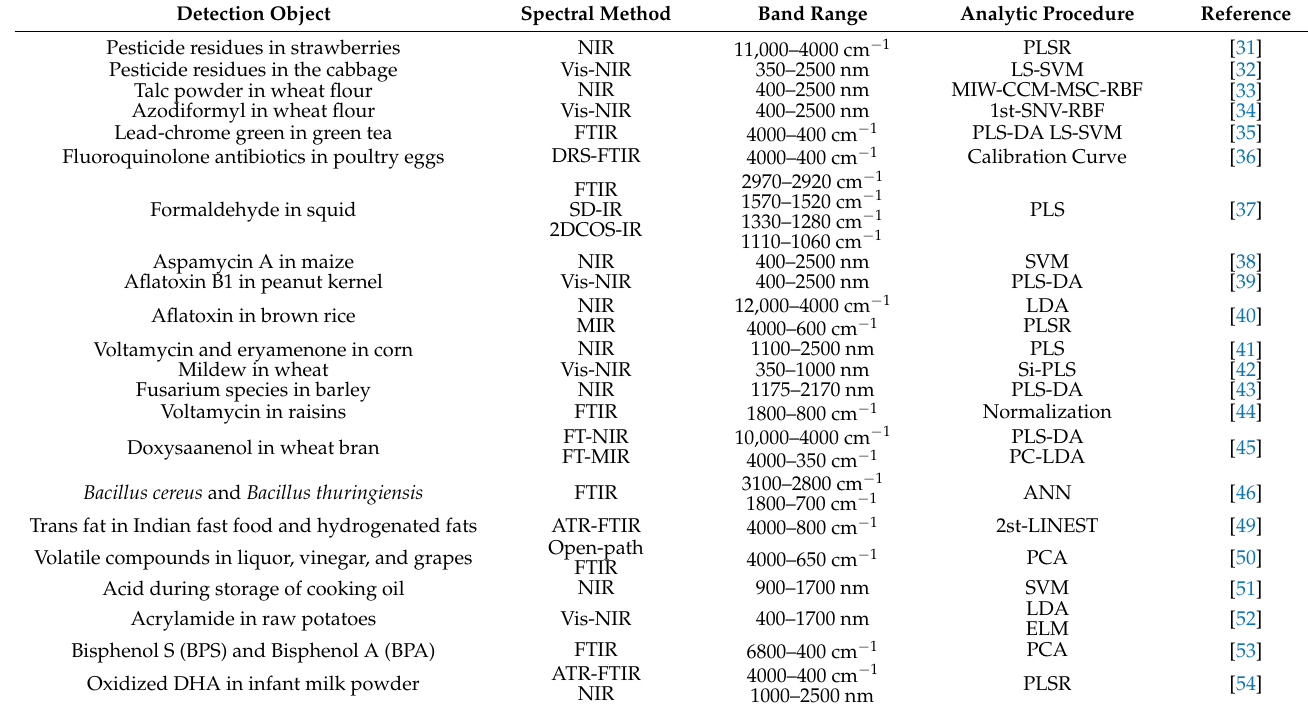
Table 1. Application of infrared spectroscopy for the detection of toxic and hazardous substances in